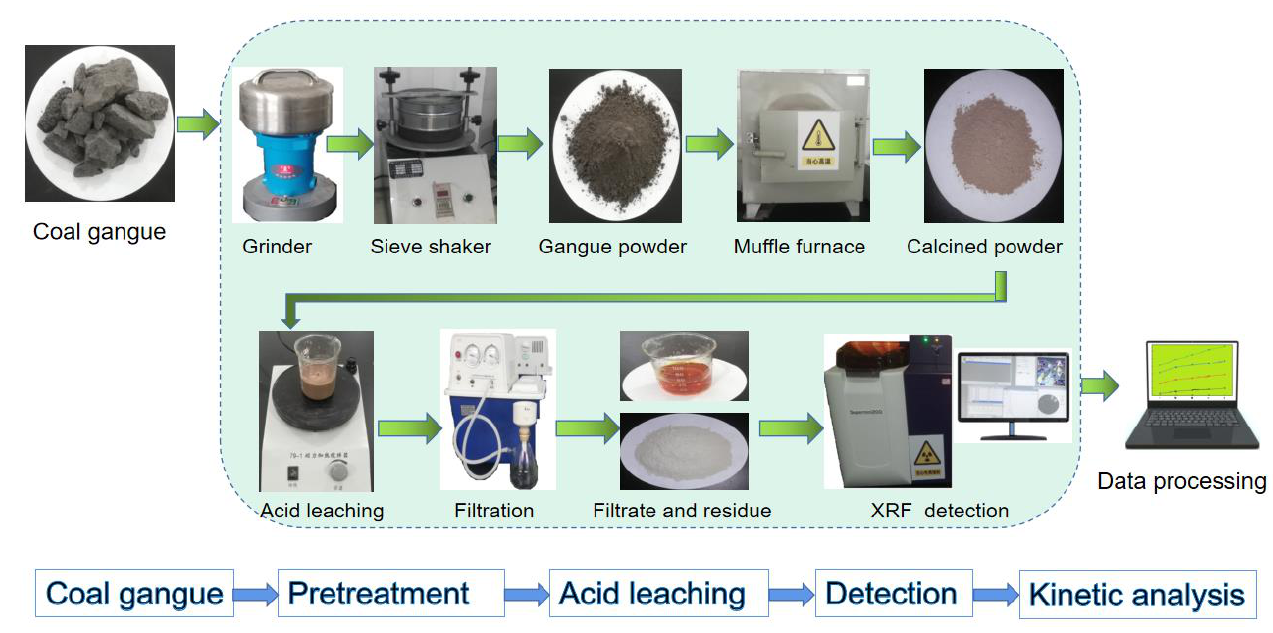
Figure 1. Flow chart of the experiments.